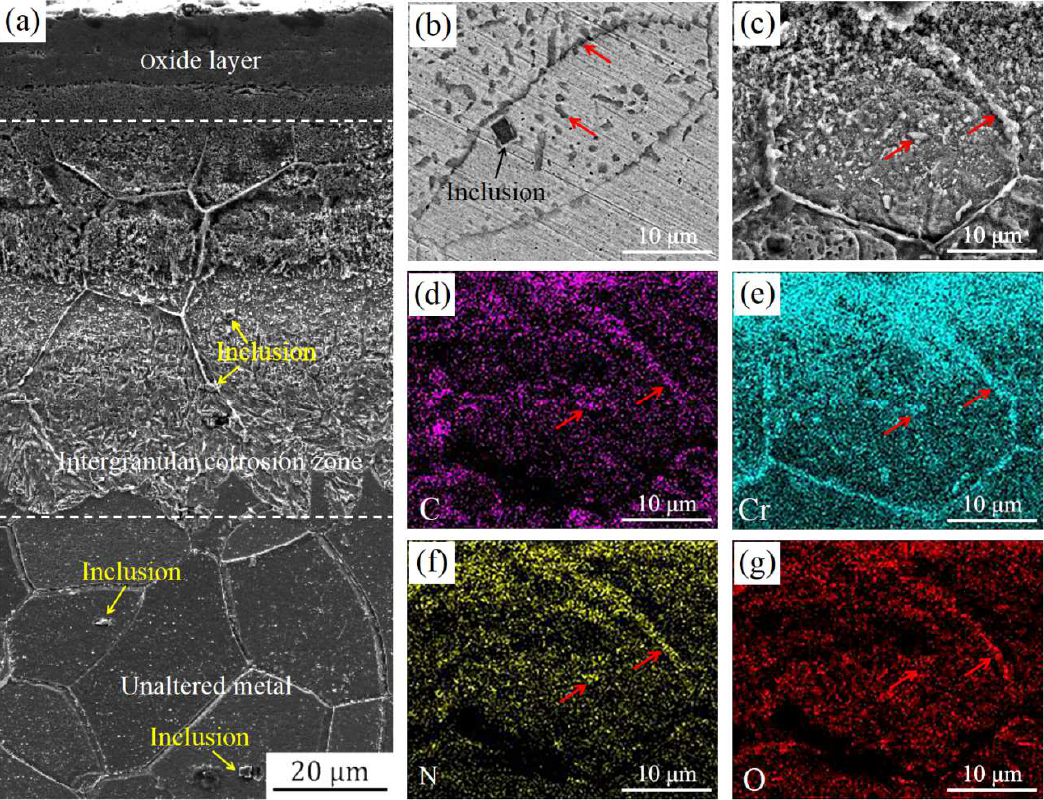
Figure 4. ( a ) Area scanning of the corrosion region in steel-3 after etching with a solution of copper chloride, hydrochloric acid, and ethyl alcohol, ( b , c ) intergranular corrosion zone before and after etching, and ( d – g ) EDS analysis of the corrosion products formed in ( c ).